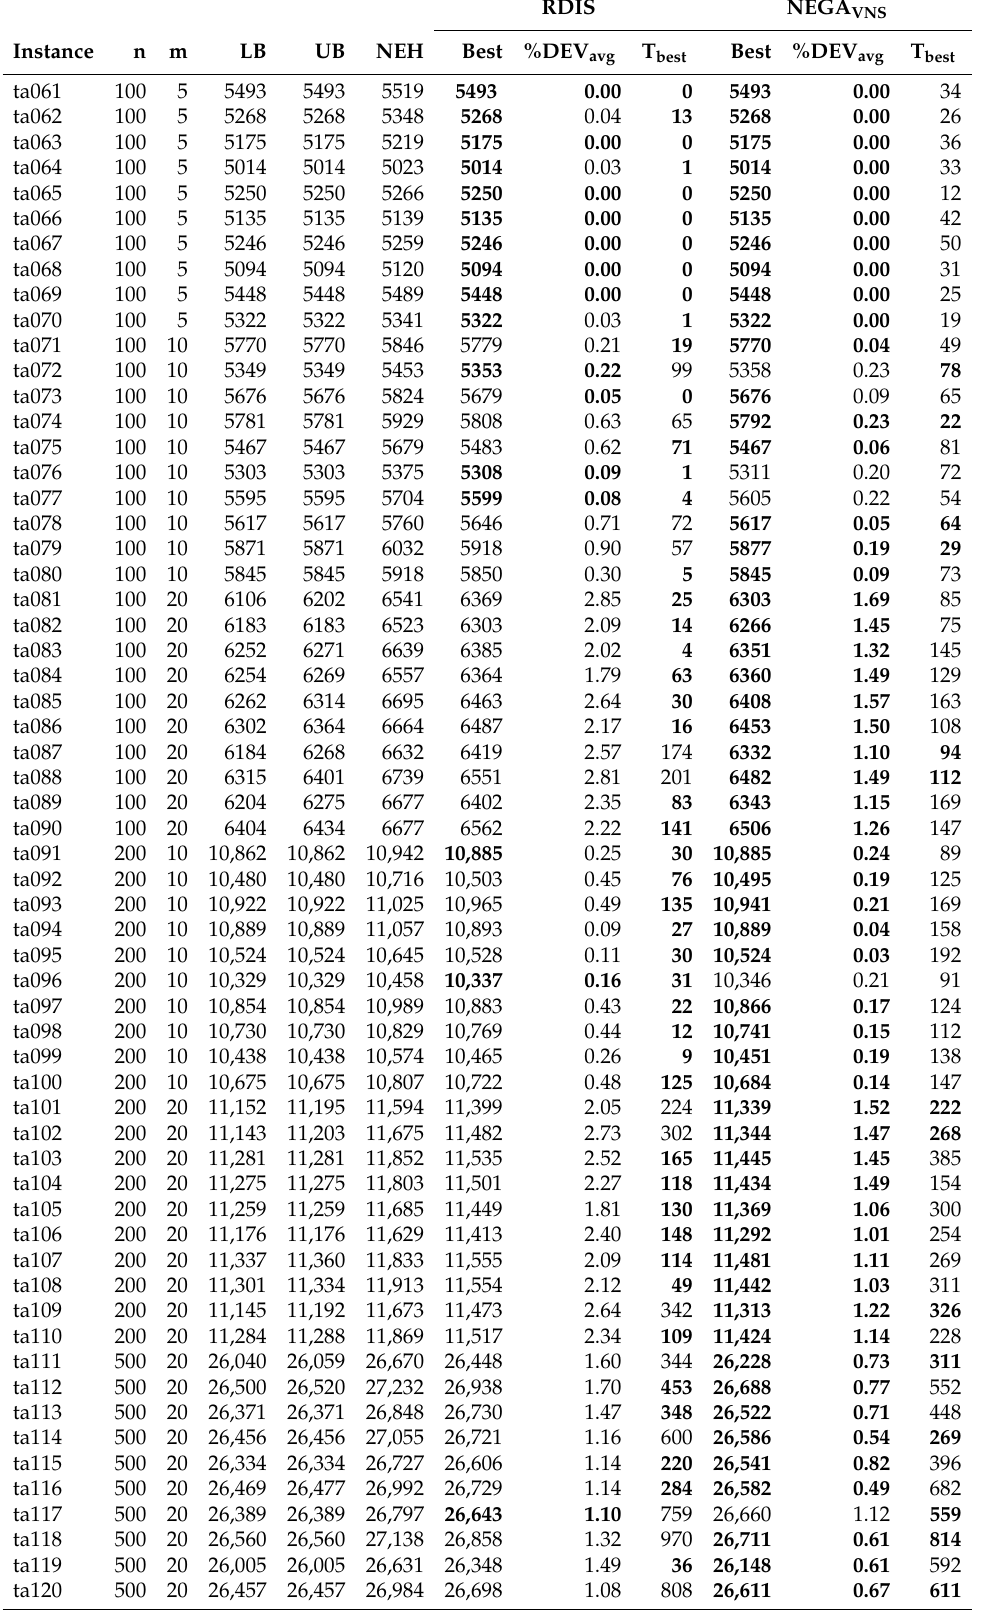
Table 7. (continued) Comparing the performance of the RDIS with that of NEGA VNS for all individual